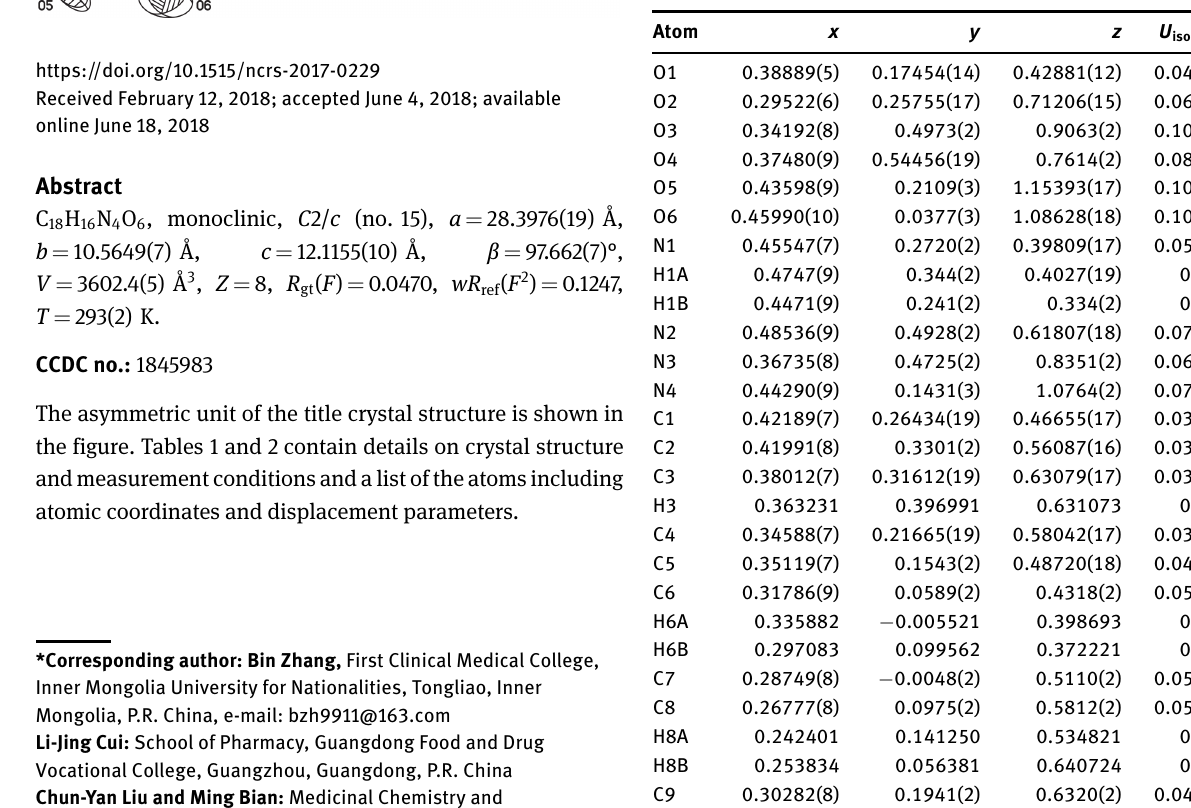
Table 2: Fractional atomic coordinates and isotropic or equivalent isotropic displacement parameters (Å 2